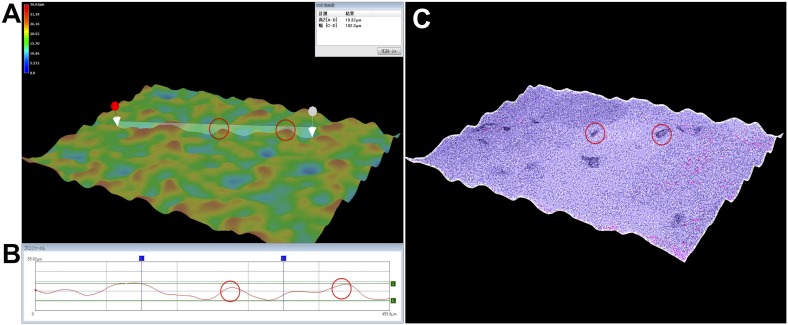
Three-dimensional images of the surface roughness of PuraMatrix with adherent neurons observed using a digital microscope.The neurons were cultured on 25% PuraMatrix in basic medium #0 for 1 month. Two neurons are shown by red circles. (A) Color 3D image. The highest positions are displayed in red and the lowest positions in blue (see color scale at the upper left). The maximum height difference was <40 µm. (B) Cross-sectional profile between the two arrows in A showing a height of 19.32 µm (A–B) and a width of 455.8 µm (C–D: 182.3 µm). The neurons and PuraMatrix show a typical height difference, or surface roughness, of approximately 10–20 µm. (C) High contrast 3D image using the high dynamic range function. The transparent neurons are emphasized by their dark color.